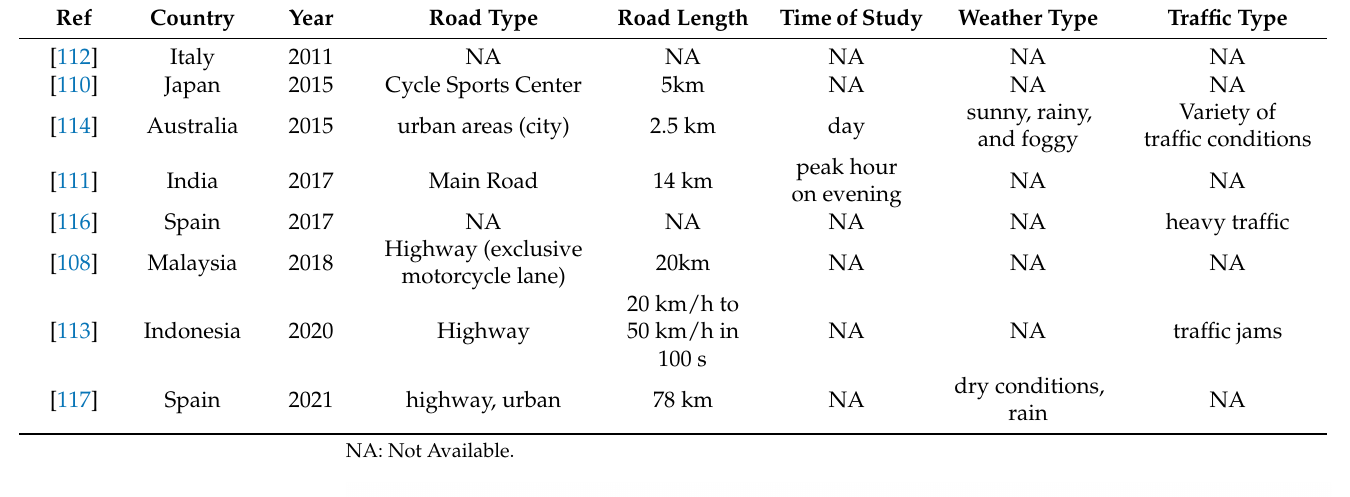
Table 4. Conditions of real-time experiments.